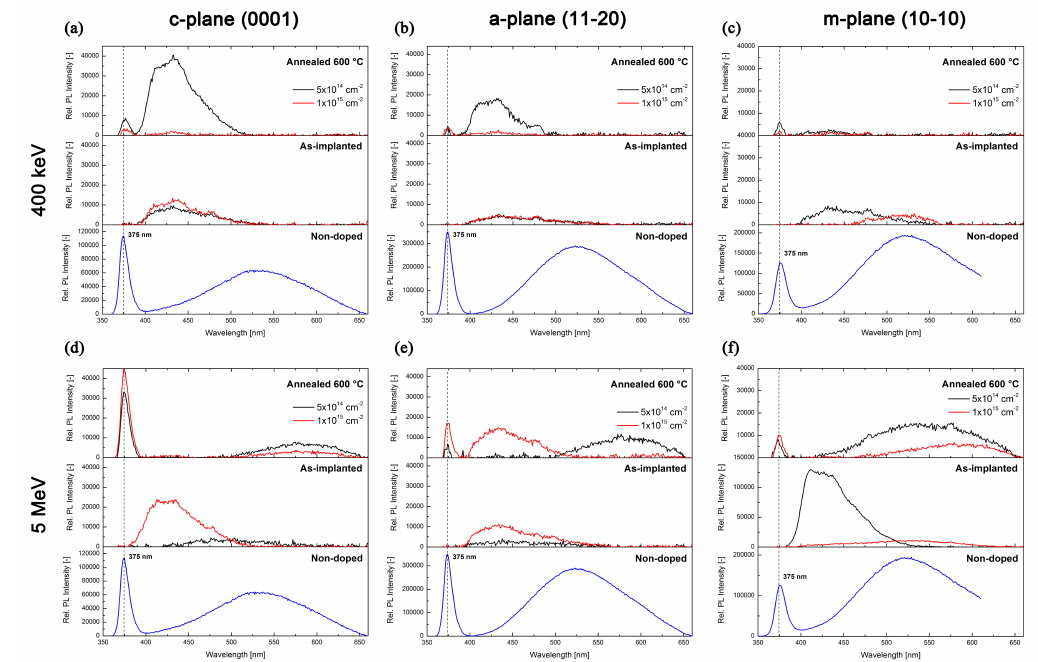
Figure 7. The photoluminescence spectra of undoped pristine ZnO samples and as-implanted and as-annealed ZnO samples doped with ( a – c ) 0.4 MeV and ( c – e ) 5 MeV Au + ions for ( a , d ) c -plane, ( b , e ) a -plane and ( c , f ) m -plane crystallographic cuts of ZnO. The ion-implantation fluences used were 5 × 10 14 and 1 × 10 15 cm − 2